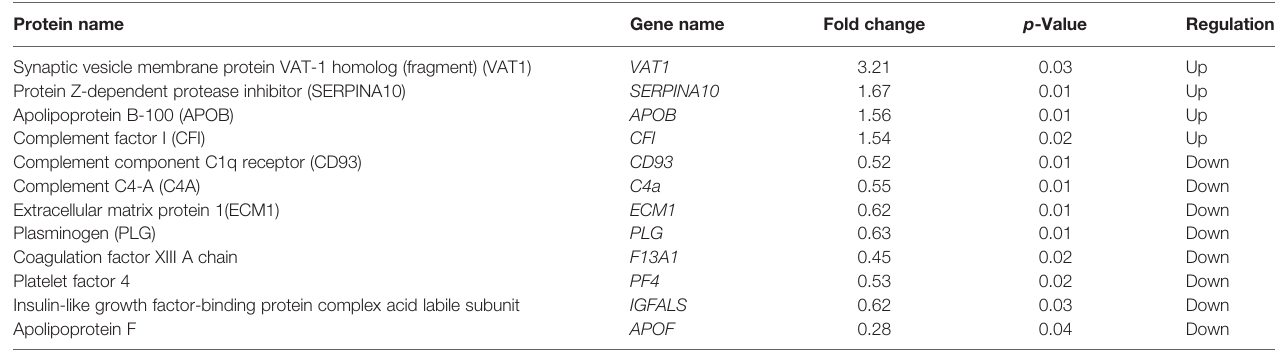
TABLE 3 | Identi fi cation information for differentially expressed proteins between PTC and